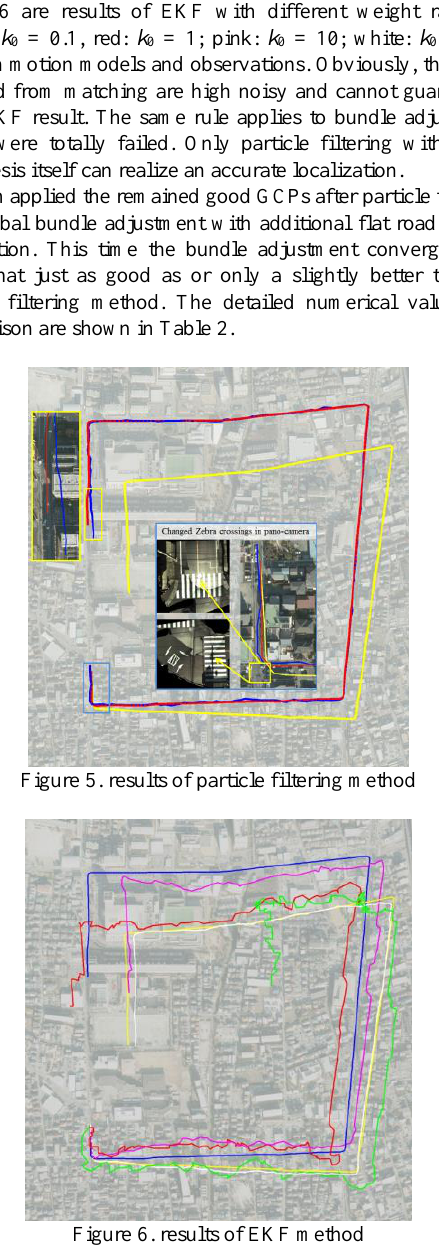
Figure 6 are results of EKF with different weight ratios k 0